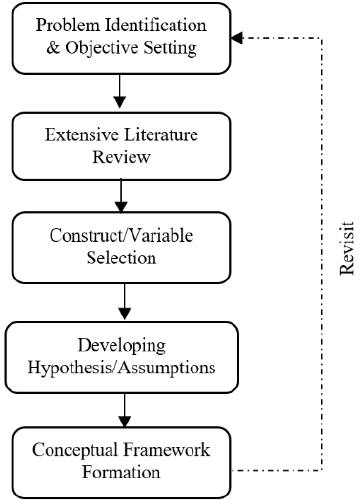
Figure 2. Research